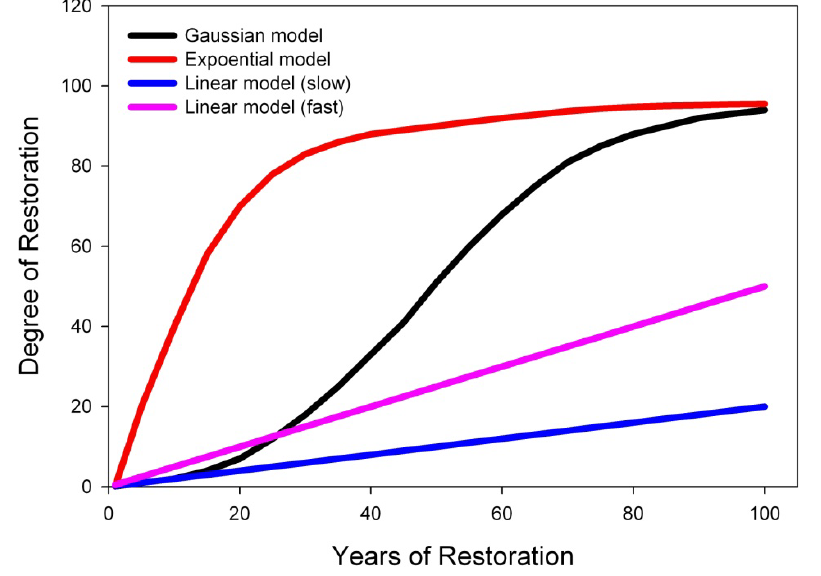
Figure 9. Hypothetical trajectories for restoring hydrological processes at NSNWR. See text for explanation of the assumptions and details regarding each